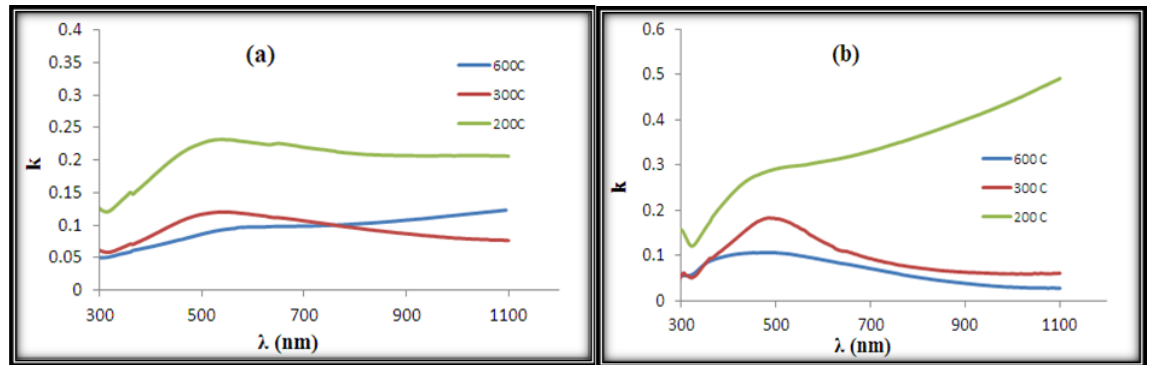
Cu O thin films 2 2 4